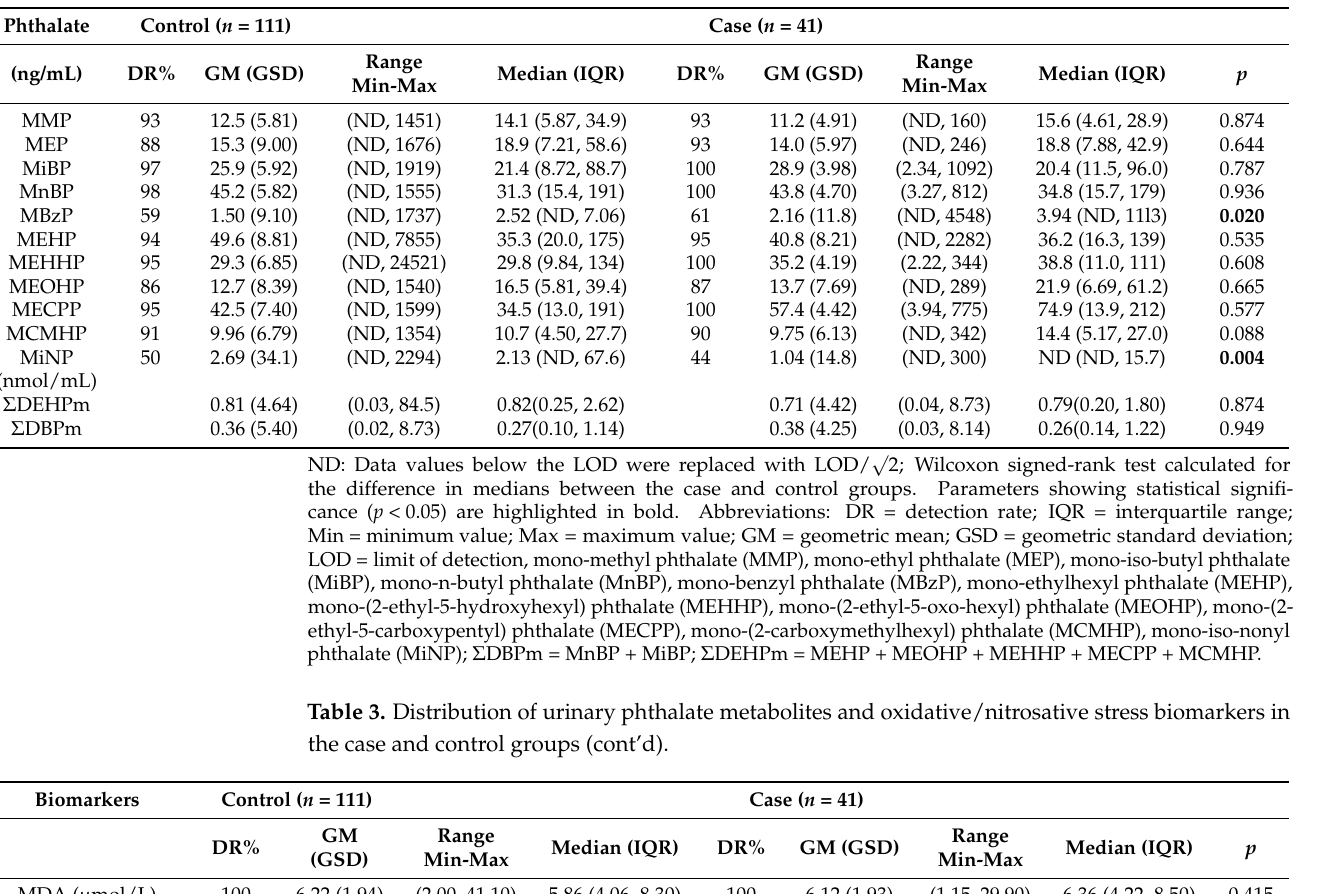
Table 2. Distribution of urinary phthalate metabolites and oxidative/nitrosative stress biomarkers in the case and control groups.